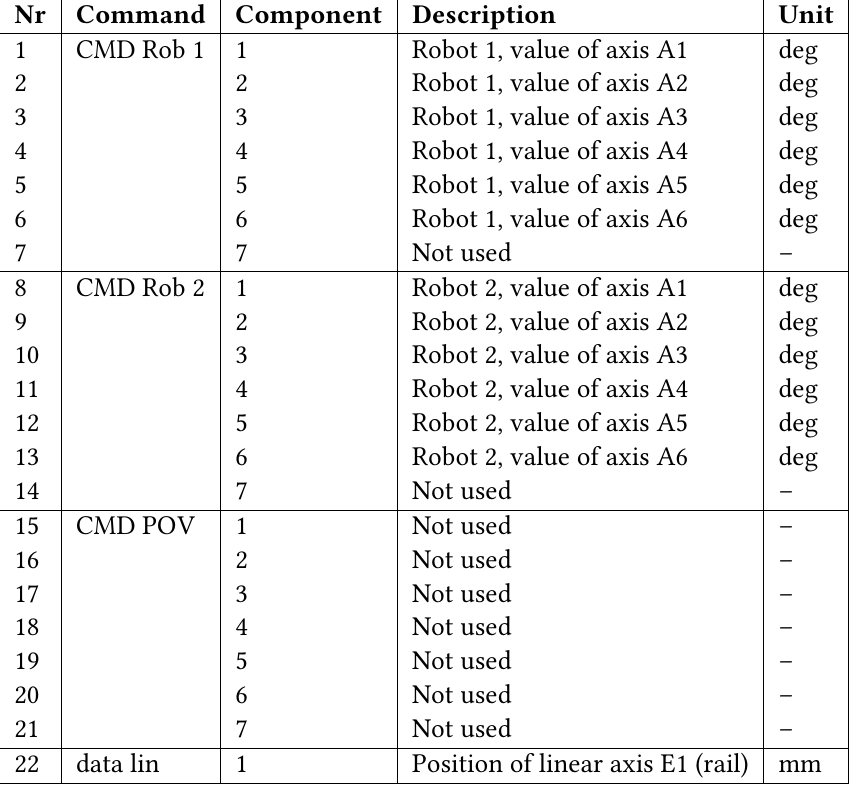
Table 6: Description of the commanding parameters in case of Ideal Joint Tool (IJT) coordinate system the robot (in mm) on the linear axis. The 7th index is not used for CMD Rob 1 and CMD Rob 2. Further, CMD POV is not used for this mode of